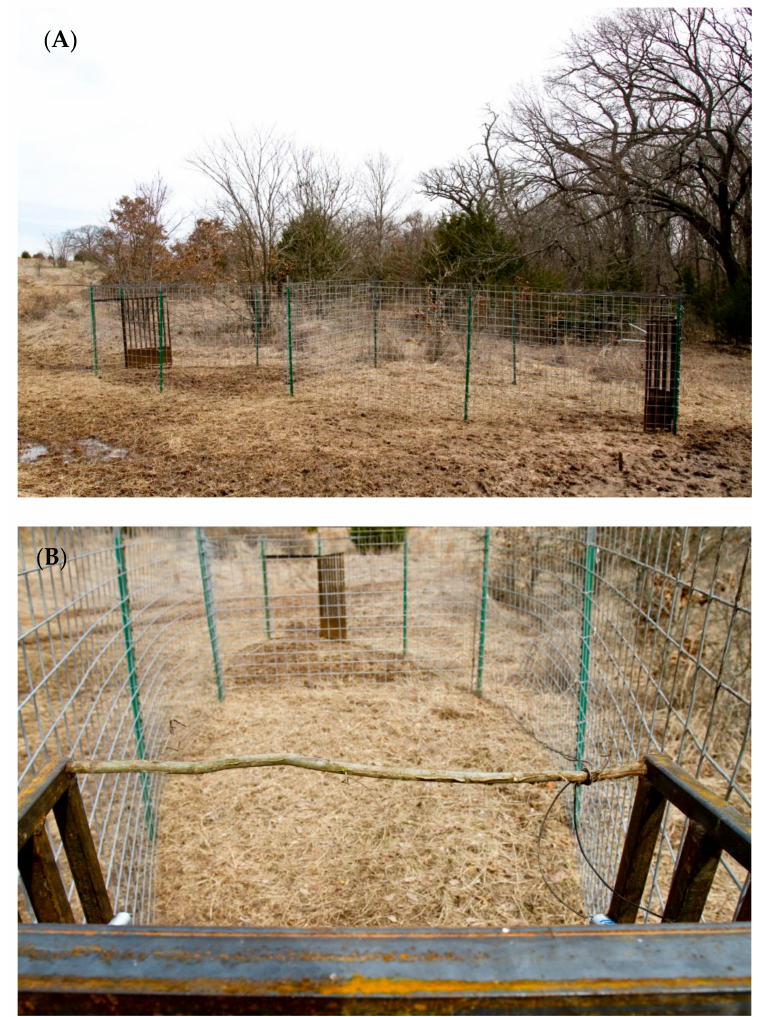
Figure 3. Corral trap (9.75 m (l) × 2.4 m (w) × 1.5 m (h)) showing overall design, adjoining compartments, and two different gate openings (single spring gate on left and saloon-style gate on right) ( A ). Interior view of the adjoining compartments with the saloon-style gate in the foreground, and the single spring gate in the background ( B ). Photographs courtesy of Noble Research Institute, LLC (Ardmore, OK,